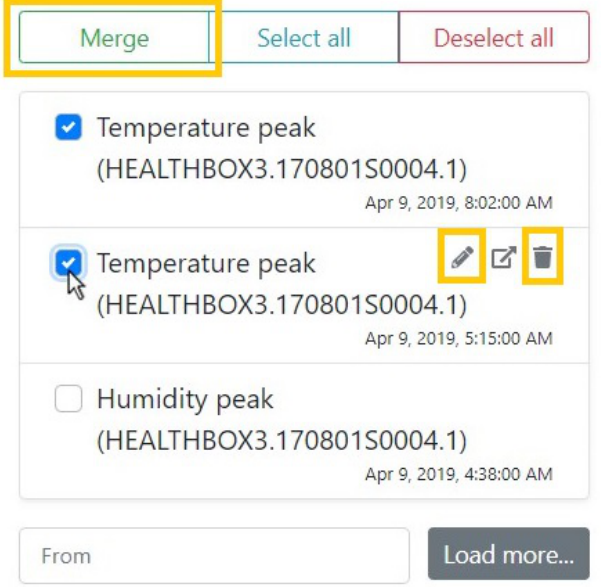
Figure 3. Options in the event alert list for a user to submit feedback: relabeling (using the pencil icon), merging (selecting multiple events and clicking the merge button) and deleting (using the trash bin